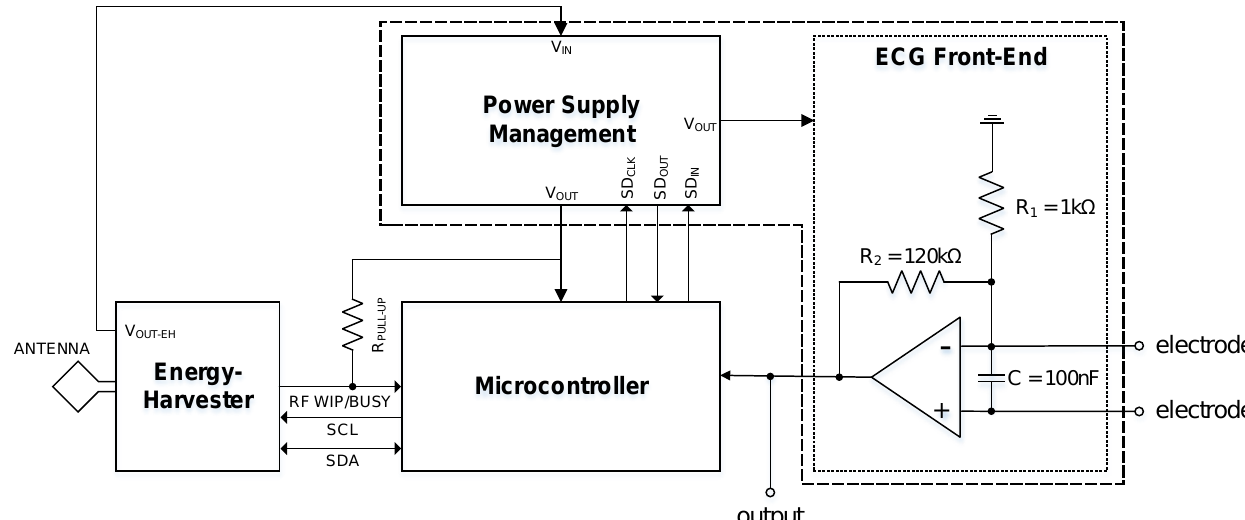
Figure 1. System architecture of the proposed concept prototype. The focus of this paper is the design and evaluation of the power supply module and the ECG front-end